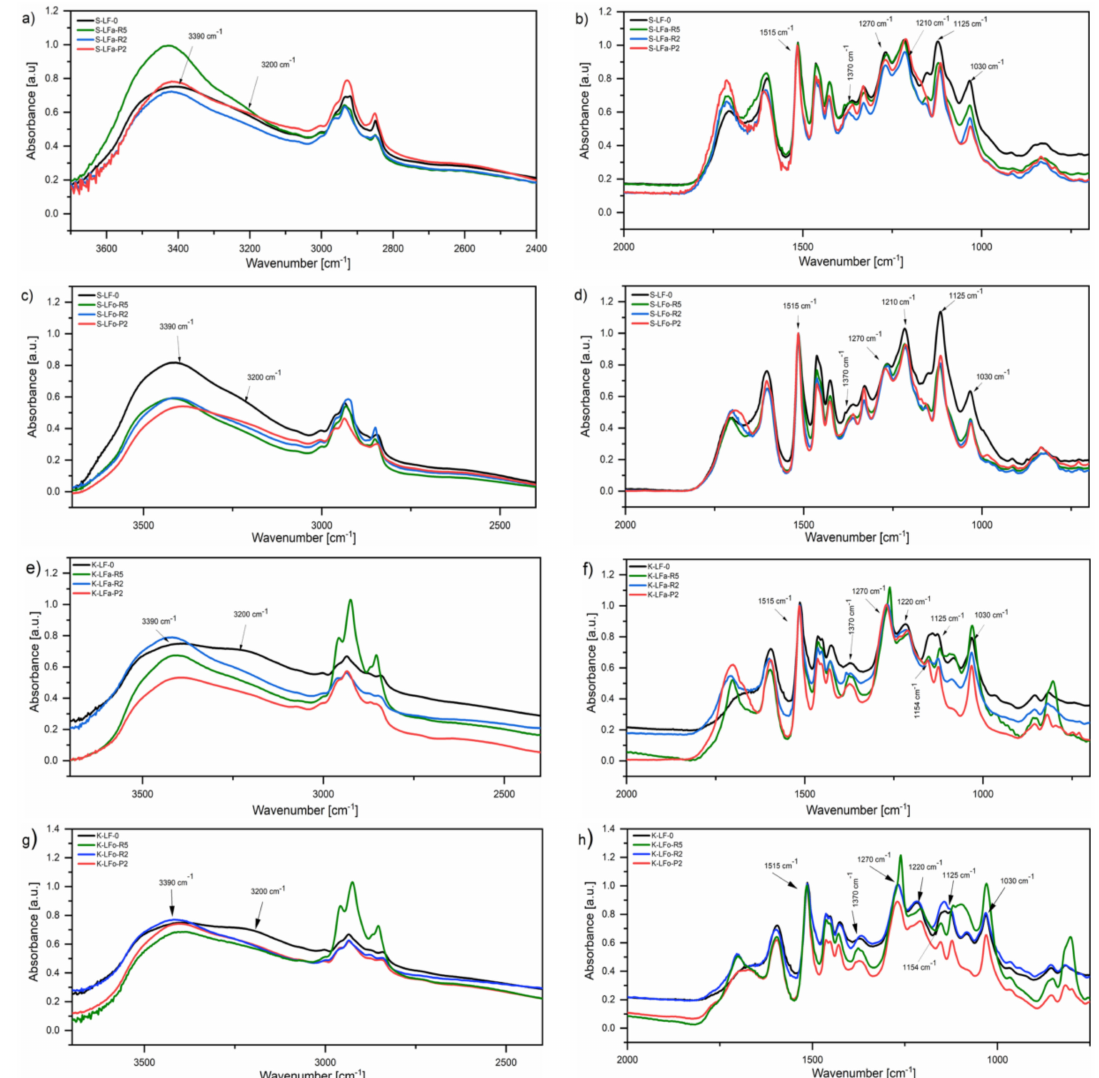
Figure 10. FT-IR spectra of soda ( a , b , c , d ) and kraft ( e , f , g , h ) lignin fractions recovered from the aqueous process ( a , b , e , f ) and the organic process ( c , d , g , h ). Di ff erent regions of the infrared spectrum are reported for